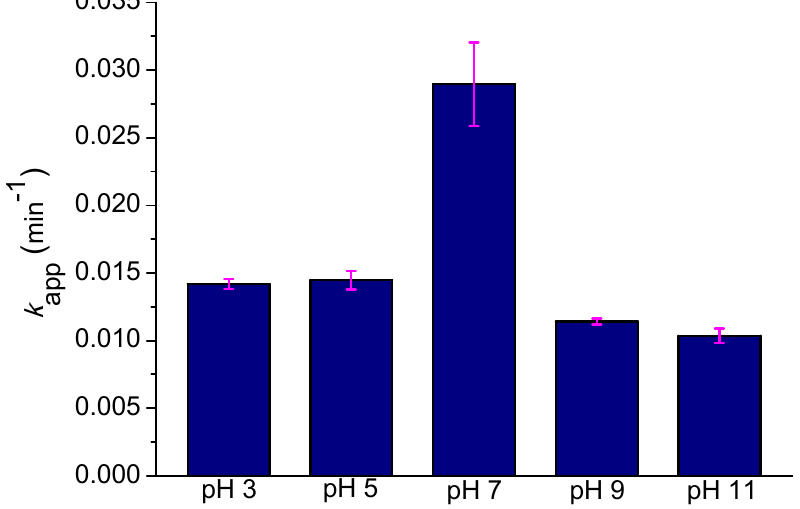
Figure 3. Effect of the initial pH on AB129 decolorization rate constant (conditions: 25 mg/L AB129, absorbance measured at 595 nm, UV 150 W). The fuchsia error bars represent the slope error.